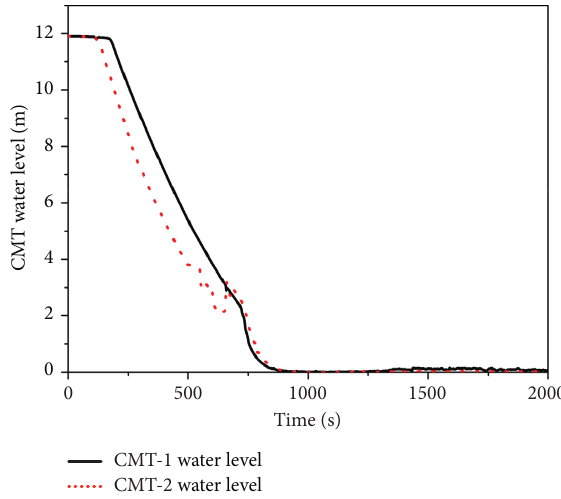
Figure 22: DEDVI line break CMT water level.